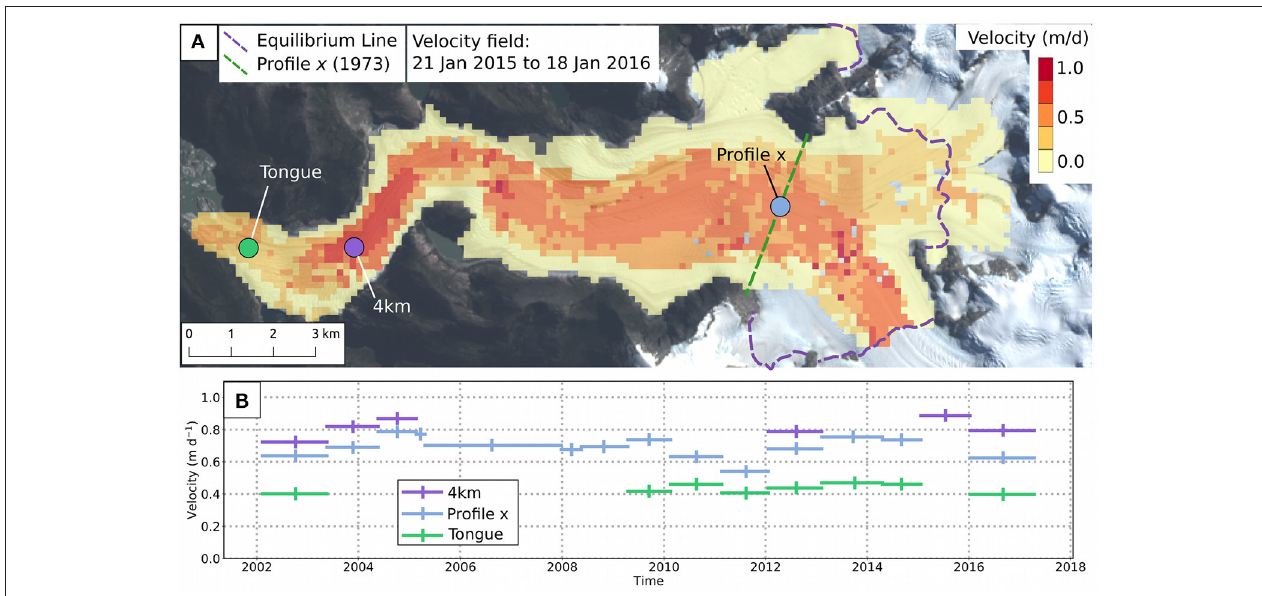
FIGURE 4 | (A) Surface velocity field of Benito Glacier produced from two Landsat 8 images acquired on 21 January 2015 and 18 January 2016. Colored circles show the locations of the three sites where velocity was sampled between 2001 and 2017. The temporal changes in surface velocity at the three sites are displayed in (B) . Horizontal bars represent the average velocity between two Landsat images. Uncertainties are represented by the vertical bars .